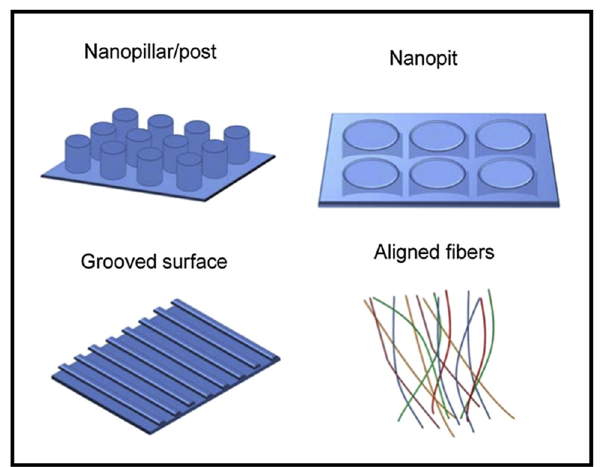
Figure 15: Schematic illustration of some nanopatterns [ 121 ] . Copyright 2016, Elsevier ™ .